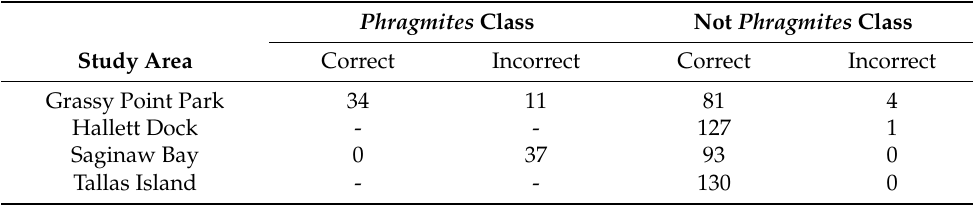
Table 11. Validated assessment points from each study area for the classification using the RGB UAS imagery, a UAS-derived CHM, and RADARSAT-2 HH polarization. Points are split by class ( Phragmites , Not Phragmites ) and if they were correctly identified (Correct,